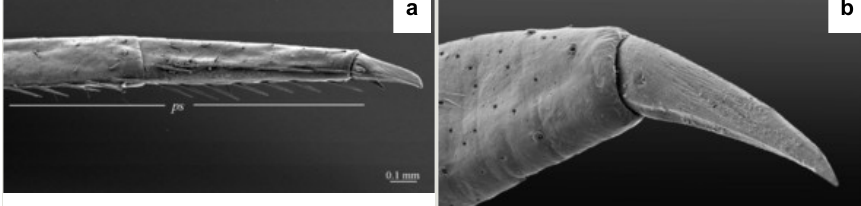
Figure 7. Eupolybothrus cavernicolus Komerički & Stoev sp. n., male paratype. a : tarsus 1, tarsus 2 and pretarsus of leg 10, lateral view. Abbreviations: pectinal setae ( ps